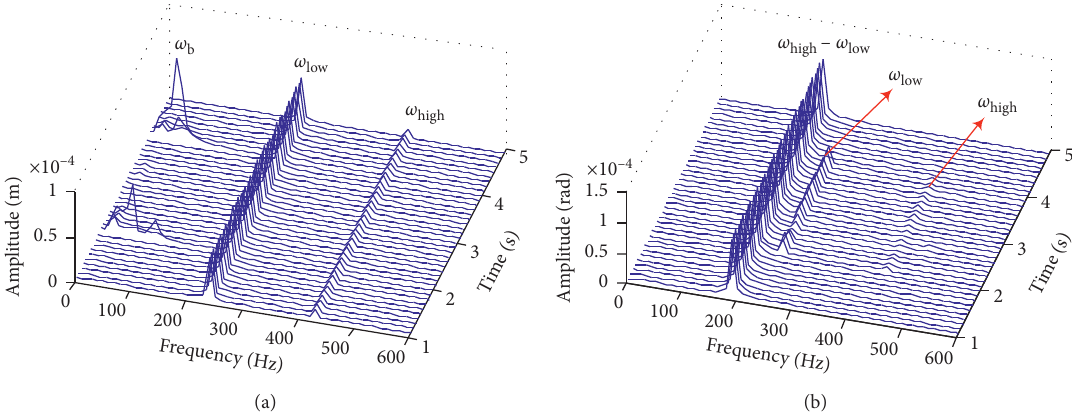
Figure 10: Transient time-frequency waterfall curves of the bending and torsional motions of the rotor system for kr � 2 × 106N/m. (a) Bending motion and (b) torsional motion.